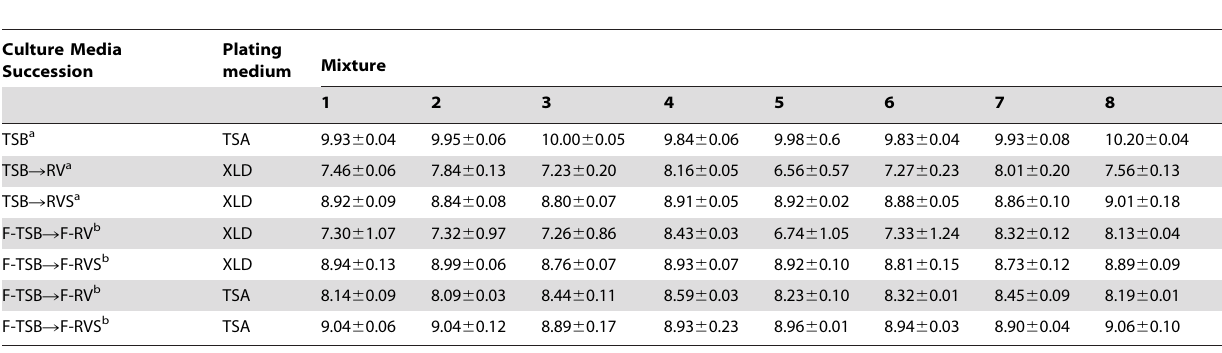
Table 3. Final cell densities (log CFU/ml) of the mixtures in TSB, RV, and RVS medium.